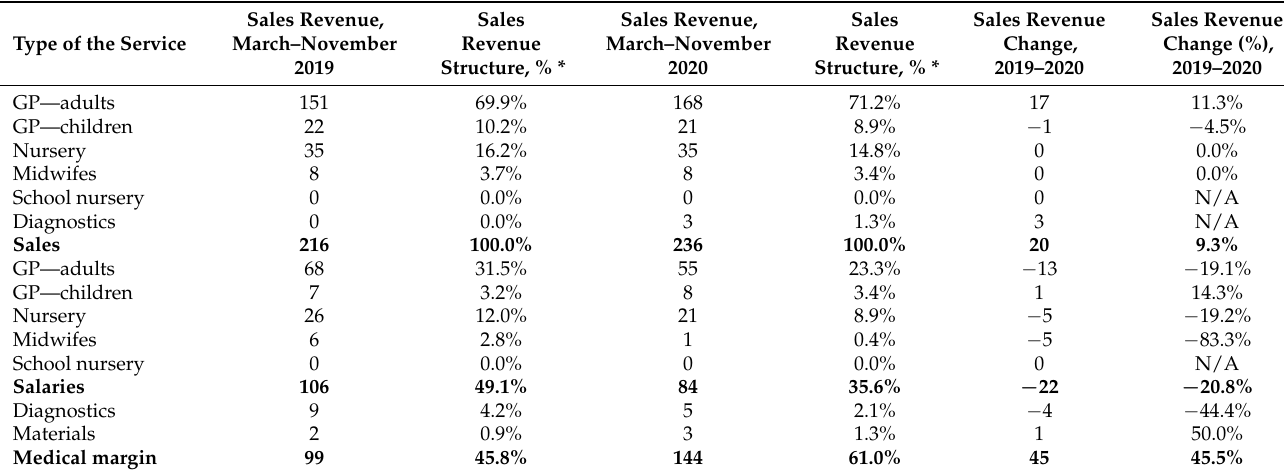
Table 5. Financial indicators of primary health care service providers (Clinic 2) in March–November 2019 and